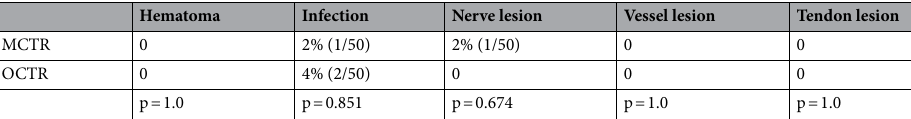
Table 3. Perioperative adverse events per group (in cases—multiple events are possible per patient). Complications are listed regarding MCTR versus OCTR. There were no statistically significant differences in the frequency of adverse events observed in either group. MCTR mini-open carpal tunnel release, OCTR Open carpal tunnel